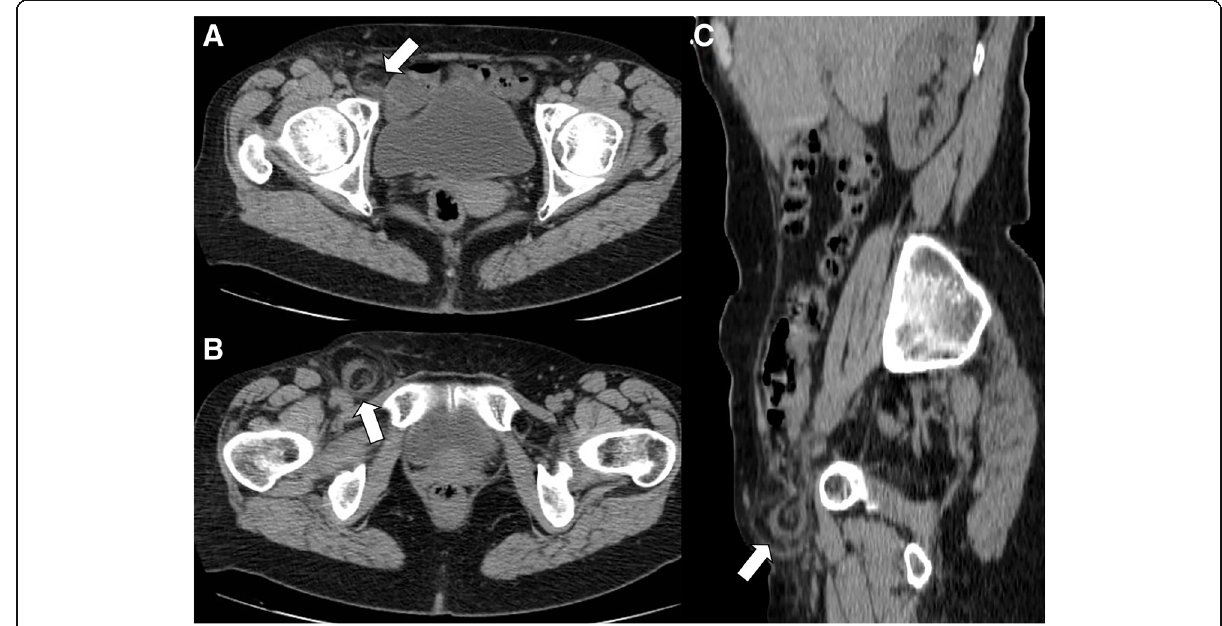
Fig. 10 Acute epiploic appendagitis in a 59-year-old woman. Axial non-contrast CT images at two different levels ( a , b ) and sagittal reformatted image ( c ) show a right inguinal hernia containing an epiploic appendage surrounded by a thin hyperdense rim (arrows). Fat stranding is seen within the hernia sac. Surgical hernia repair and pathological examination confirmed the presence of an epiploic appendagitis incarcerated in inguinal hernia